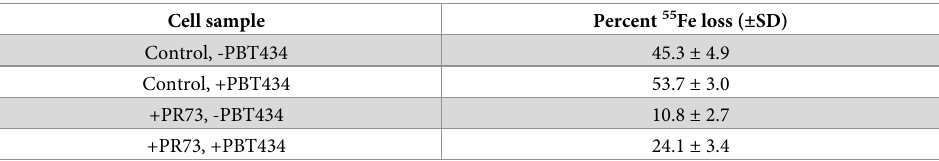
Table 2. hBMVEC 55 Fe-efflux (data from Fig